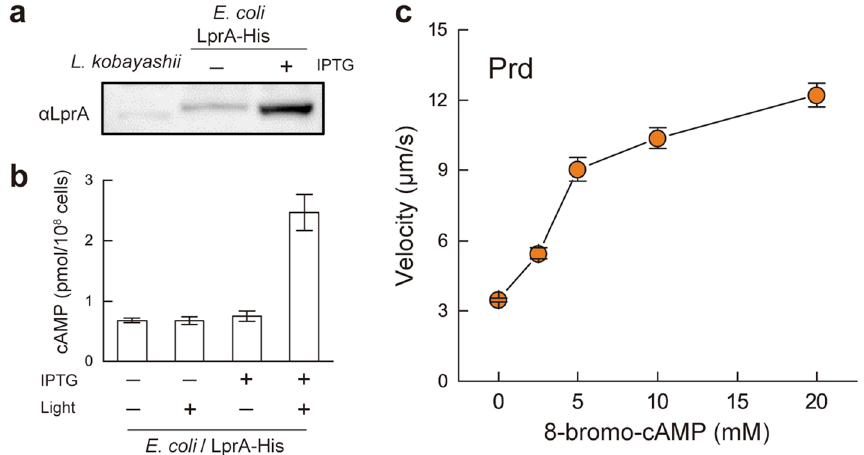
Figure 3. Enzyme activity of LprA. ( a ) Immunoblotting of whole-cell lysates of L. kobayashii (1.5 × 10 8 cells) and E. coli expressing LprA-His (2.0 × 10 7 cells) with anti-LprA antiserum. Since long-time exposure was required for detecting the band of L. kobayashii , the E. coli sample was diluted at 1:10 for observing the band of the overexpressed proteins clearly. ( b ) Light-dependent synthesis of cAMP in E. coli carrying the codon- optimized lprA . The average values and standard deviations were determined by three independent experiments. “IPTG − ” and “Light − ” are the uninduced and unilluminated controls, respectively. ( c ) Effect of externally supplemented membrane-permeable cAMP analog (8-bromo-cAMP) on the Prd swimming. Video recording was started less than 1 min after the addition of 8-bromo-cAMP. The average values and standard errors were determined by three independent experiments (ca. 100 cells were measured in total in each concentration).